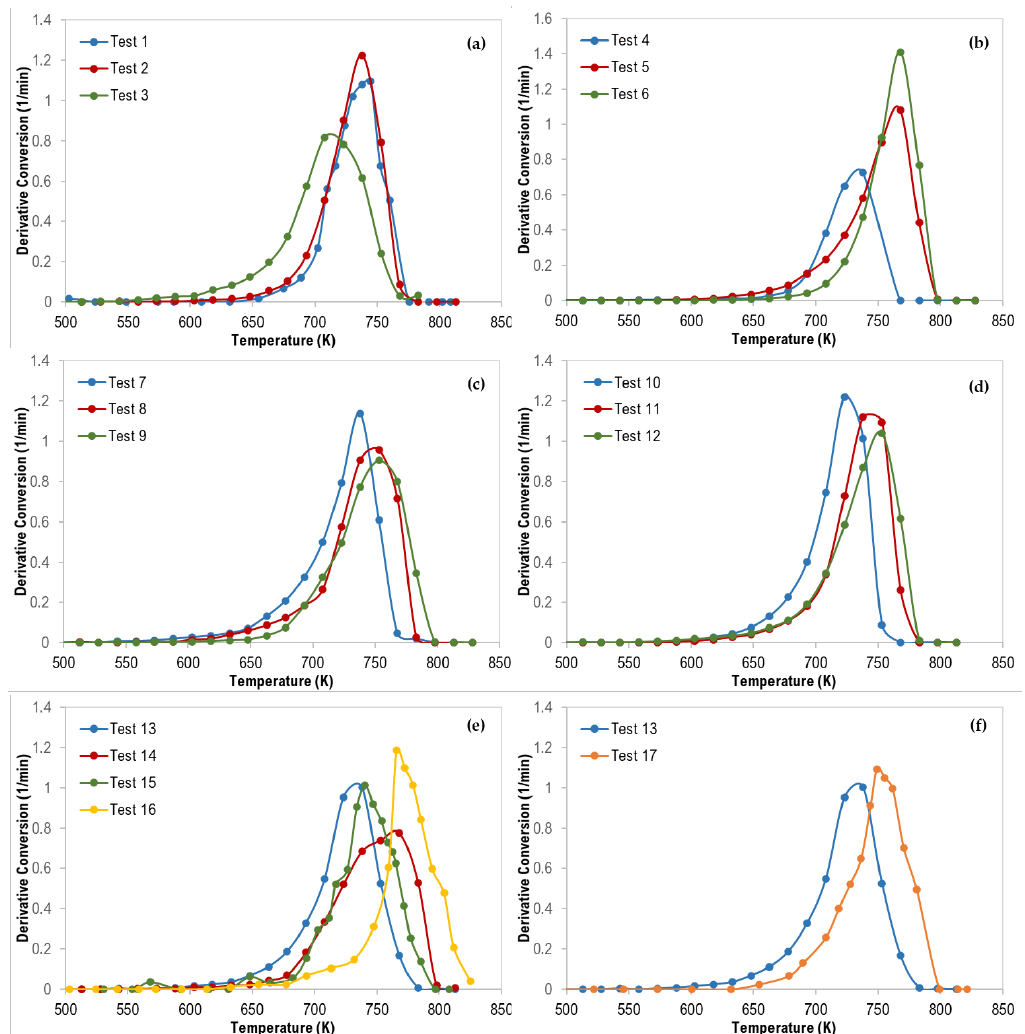
Figure 5. Derivative Thermogravimetric (DTG) curves of polymer mixtures: ( a ) 70 wt% PS, ( b ) 70 wt% LDPE, ( c ) 70 wt% HDPE, ( d ) 70 wt% PP, ( e ) ternary mixtures, and ( f ) ternary (with 33% each—Test 13) and quaternary (with 25% each—Test 17) mixtures .